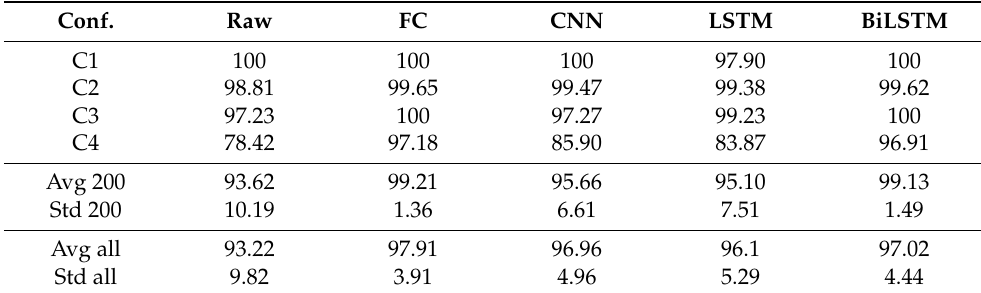
Table 14. Evaluation of the supervised classifier: F1 score for each